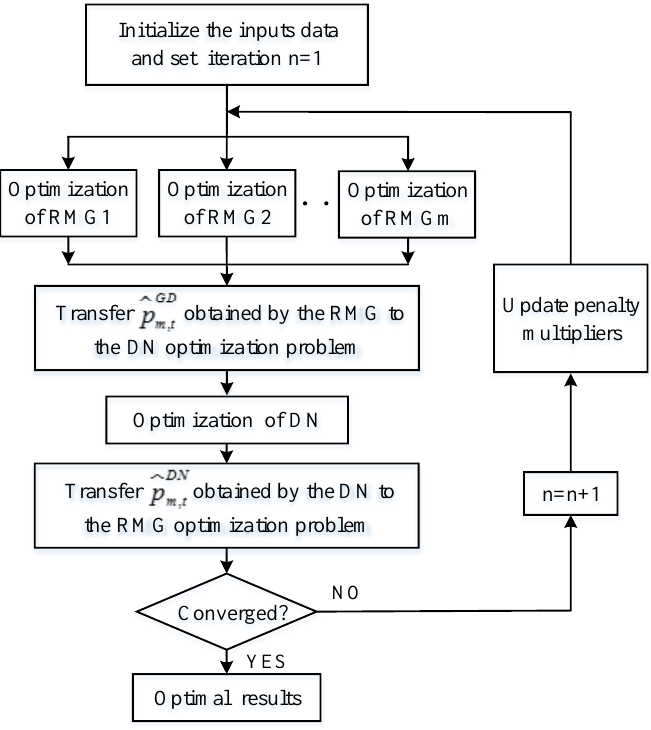
Figure 5. Flowchart of analytical target cascading (ATC)-based distributed optimal coordinated operation of ADN with multi-RMGs.